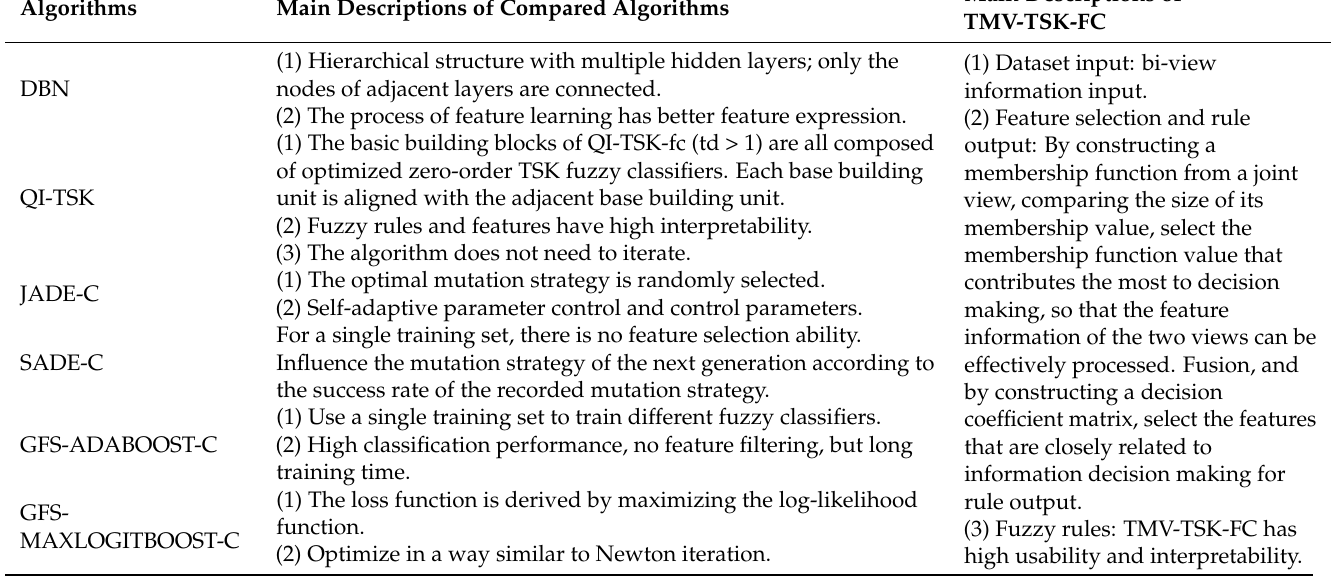
Table 4. Algorithm